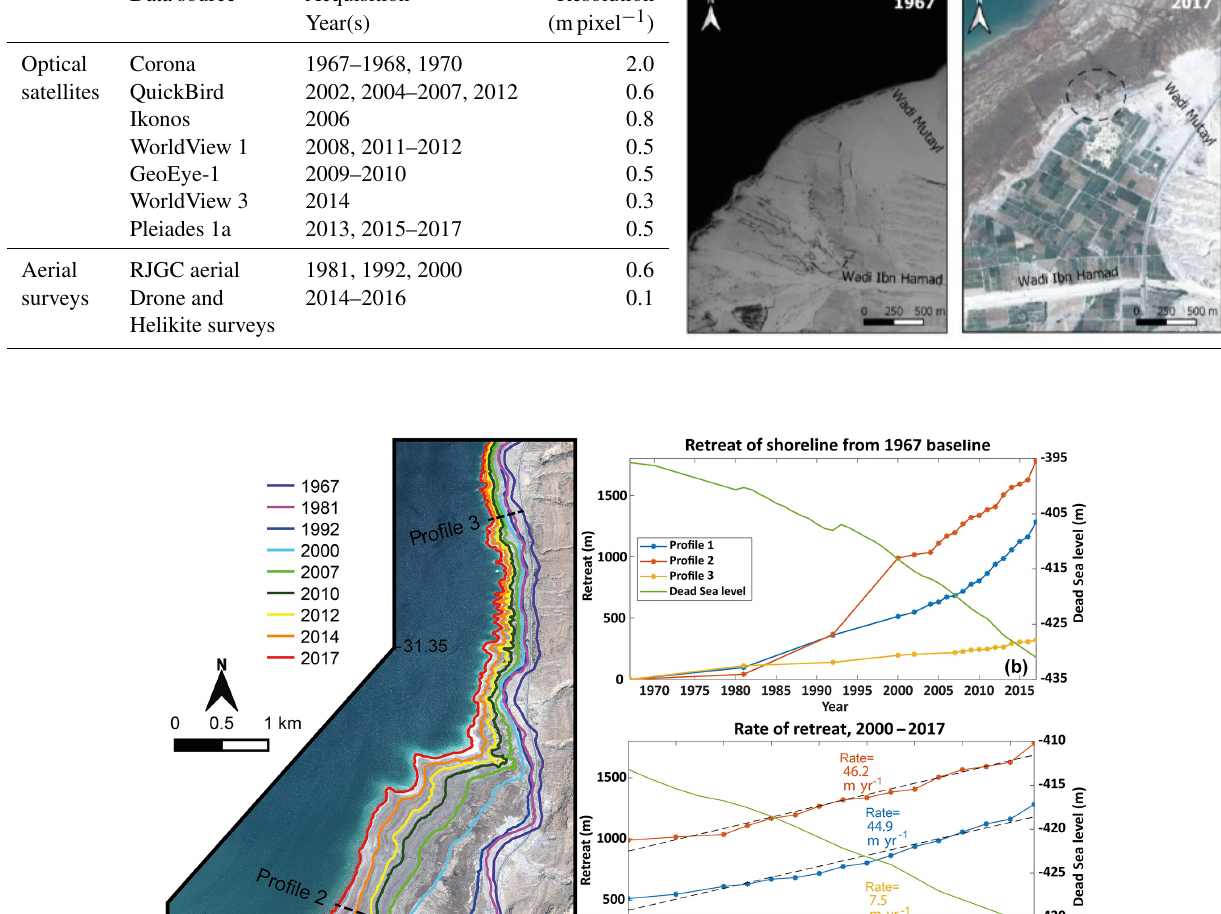
Solid Earth, 10, 1451–1468,